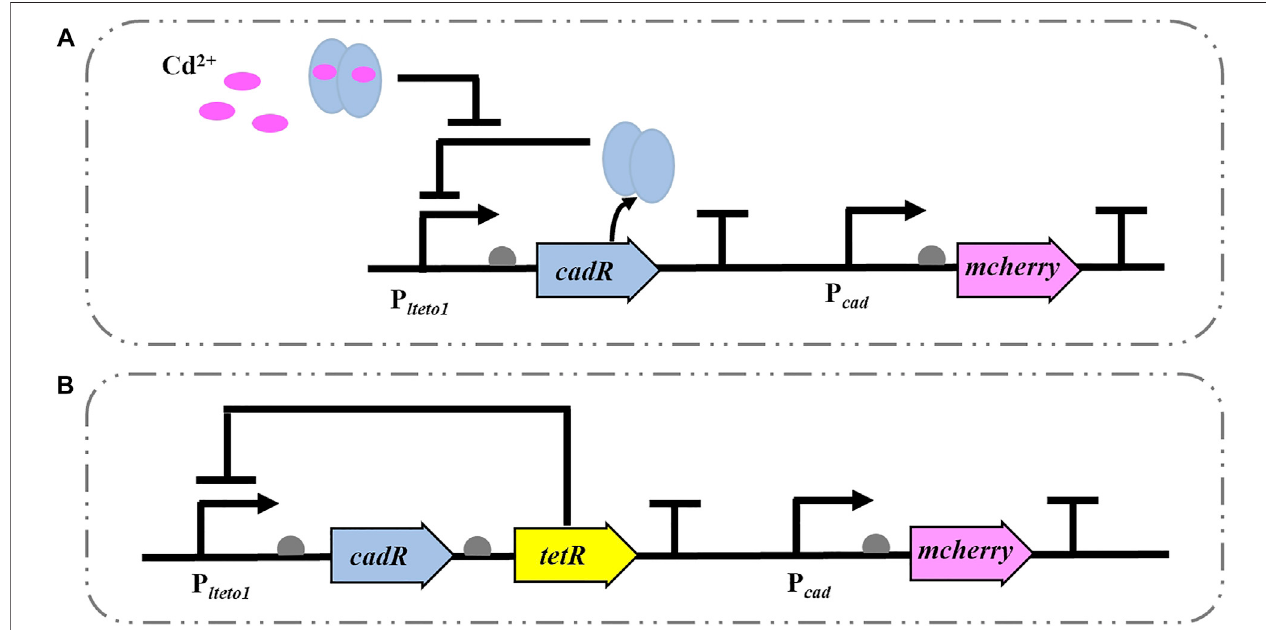
FIGURE 1 | Schematic diagram of a Cd 2+ WCB without (A) and with negative feedback (B) . (A) A typical Cd 2+ WCB CM consists of the promoter P lteto1 , the regulator cadR, cadR-regulated promoter P cad , and the reporter gene mcherry. (B) The negative feedback WCB TCM additionally incorporates a negative feedback ampli fi er that uses the tetracycline repressor protein TetR to regulate the speci fi c promoter P lteto1